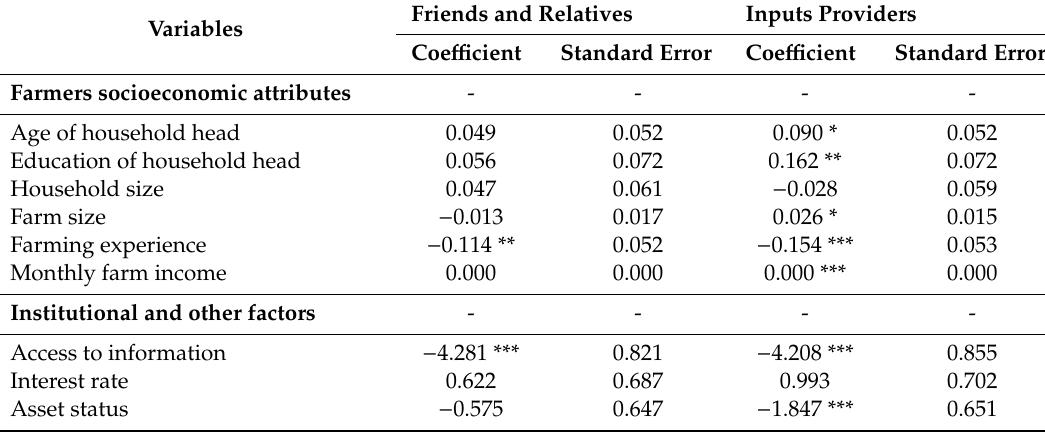
Table 4. Results of the multinomial logit